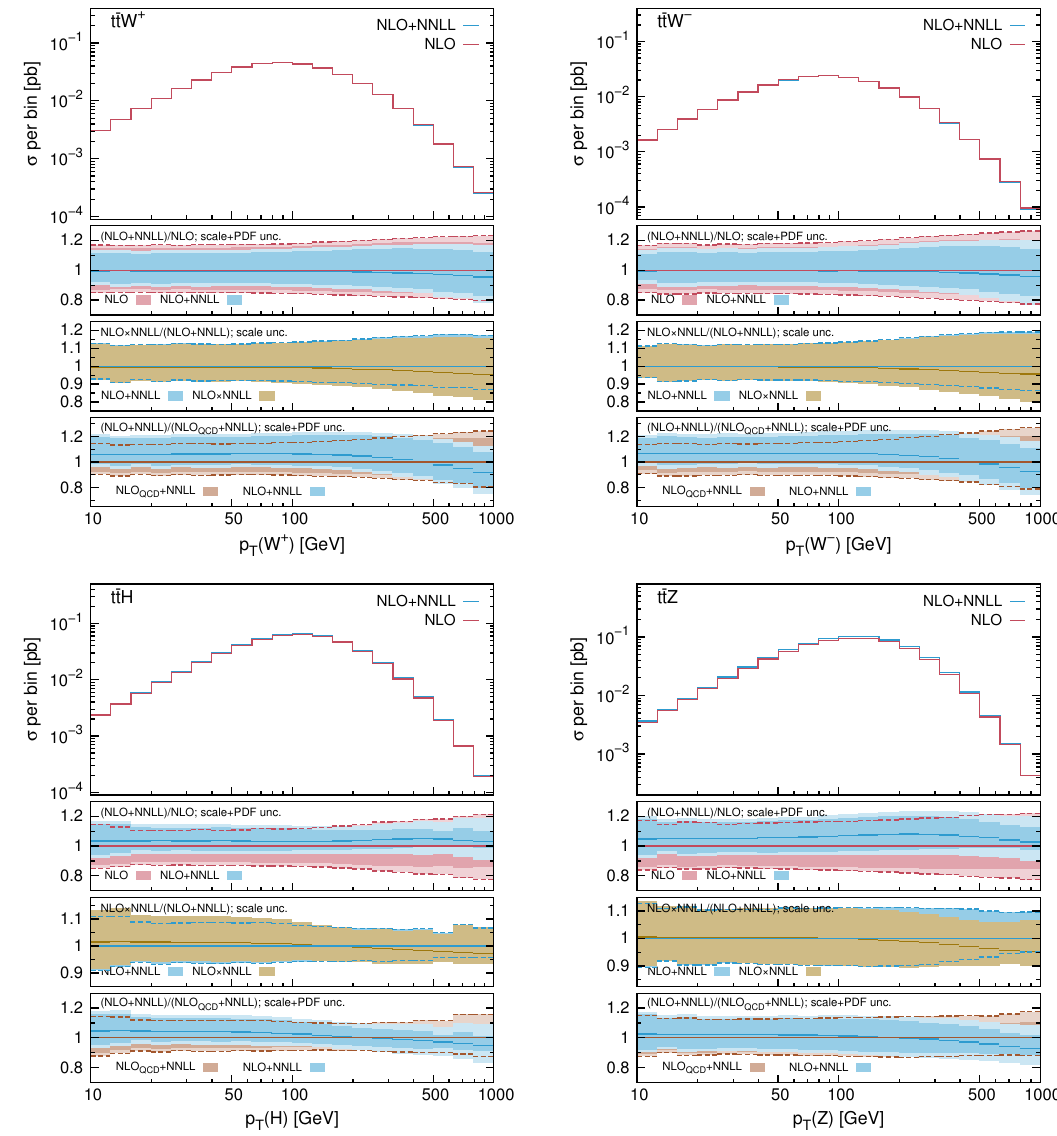
Figure 6 . Distributions di(cid:11)erential w.r.t. the transverse momentum of the EW boson. Same structure as in (cid:12)gure